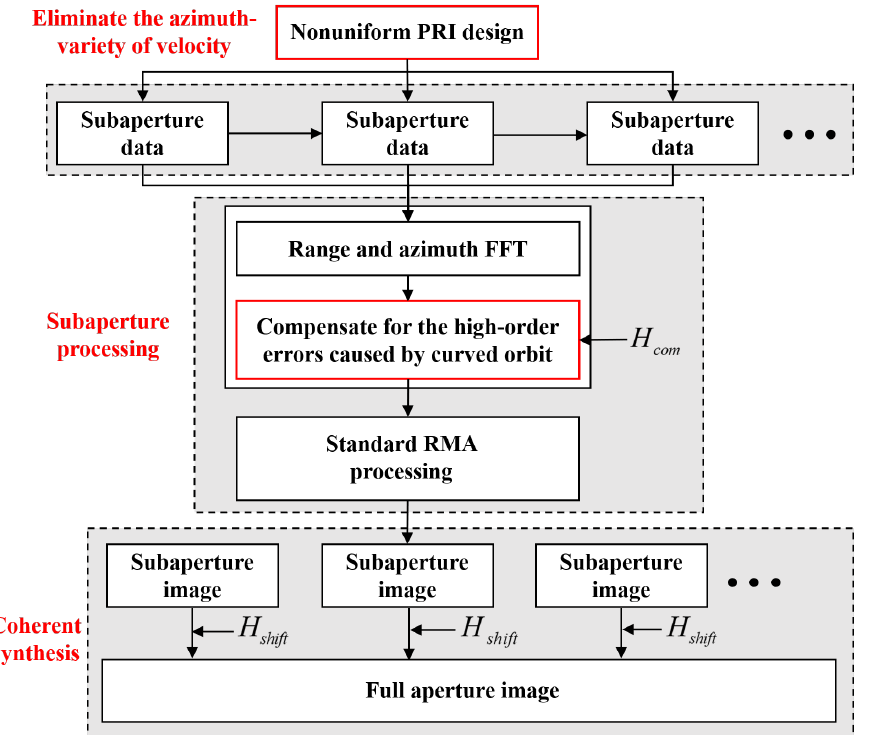
Figure 2. Flowchart of the proposed real-time imaging